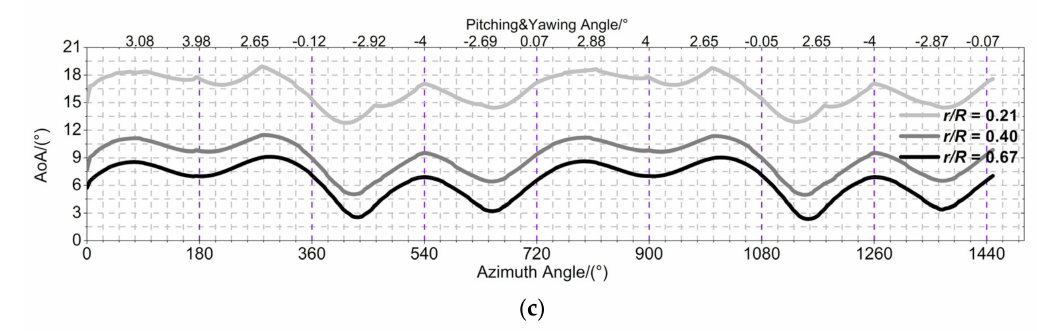
Figure 12. Variation in AOA at different spans of platform motions. ( a ) pitch motion; ( b ) yaw motion; ( c ) coupled pitch–yaw motion.